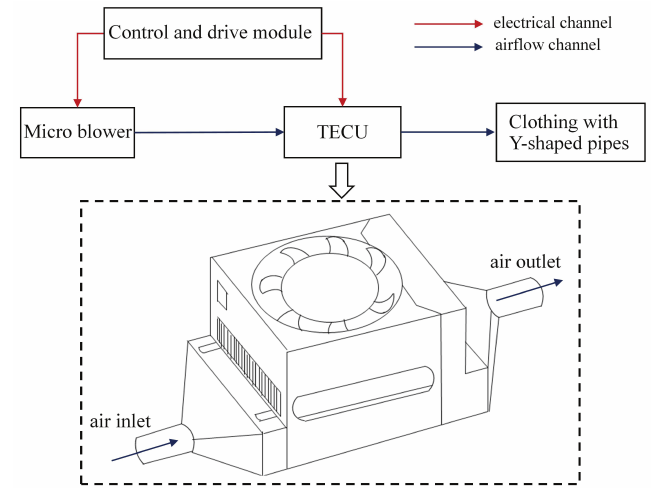
Figure 1. Diagrammatic sketch of a PCS with a TECU.